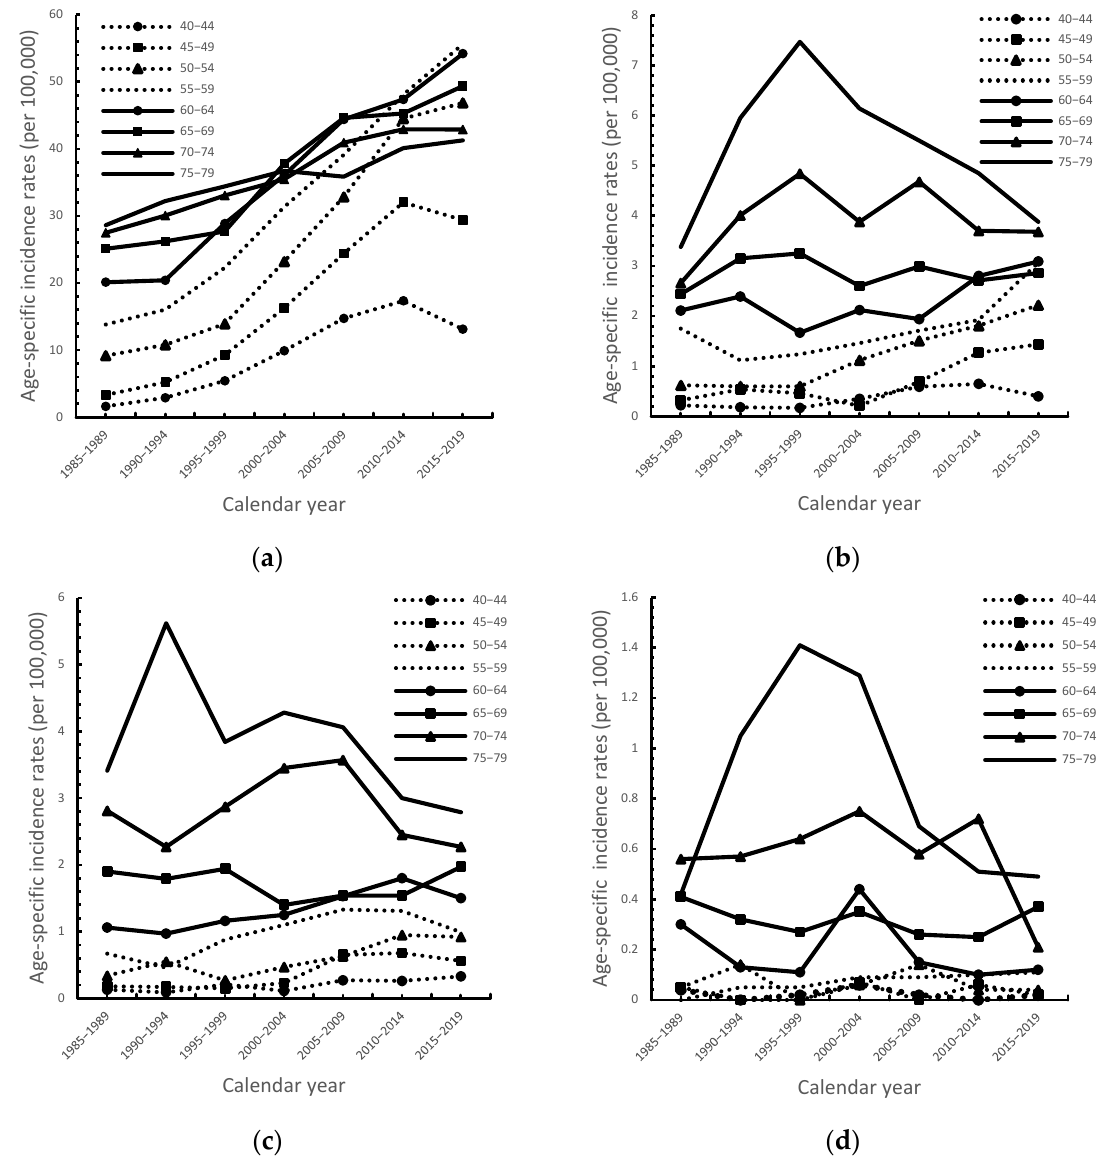
Figure 2. Age-specific incidence rates of esophageal squamous cell carcinoma (ESCC) and adenocarcinoma (EAC) in Taiwan by sex for the period 1985–2019. ( a ) ESCC in men; ( b ) ESCC in women; ( c ) EAC in men; ( d ) EAC in women. The incidence of ESCC in men increased as the birth cohort period increased (Figure